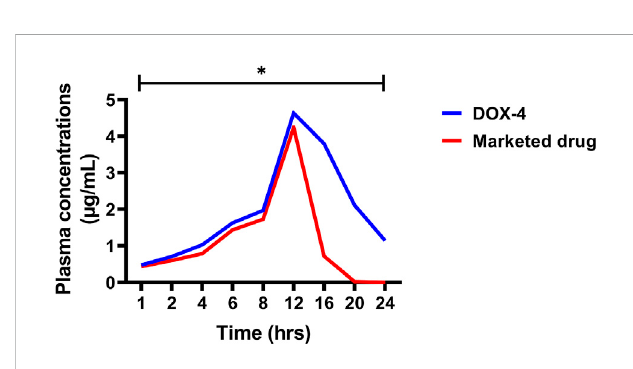
FIGURE 12 In-vivo pharmacokinetic pro fi le of doxorubicin (DOX-4) and marketed